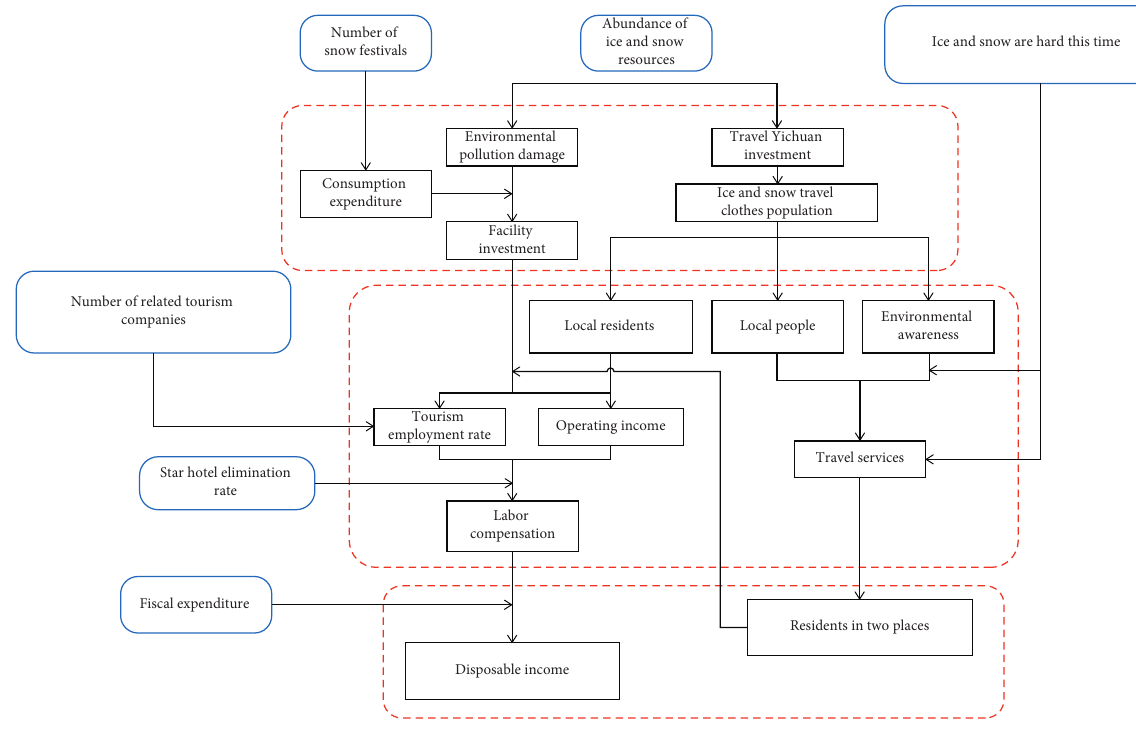
Figure 2: Ice and snow tourism market overall cause and effect diagram.